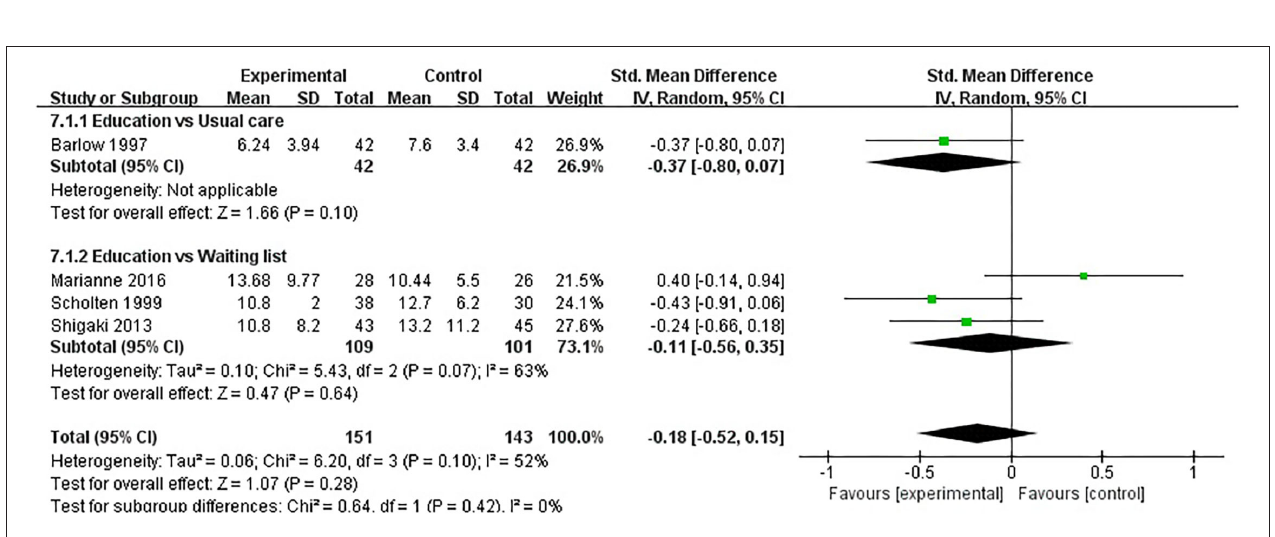
FIGURE 7 | Meta-analysis on Anxiety.